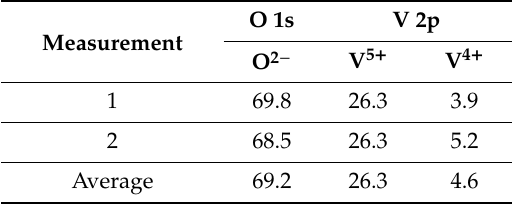
Table 1. The contribution of fitted peaks for powder sample (at.%).